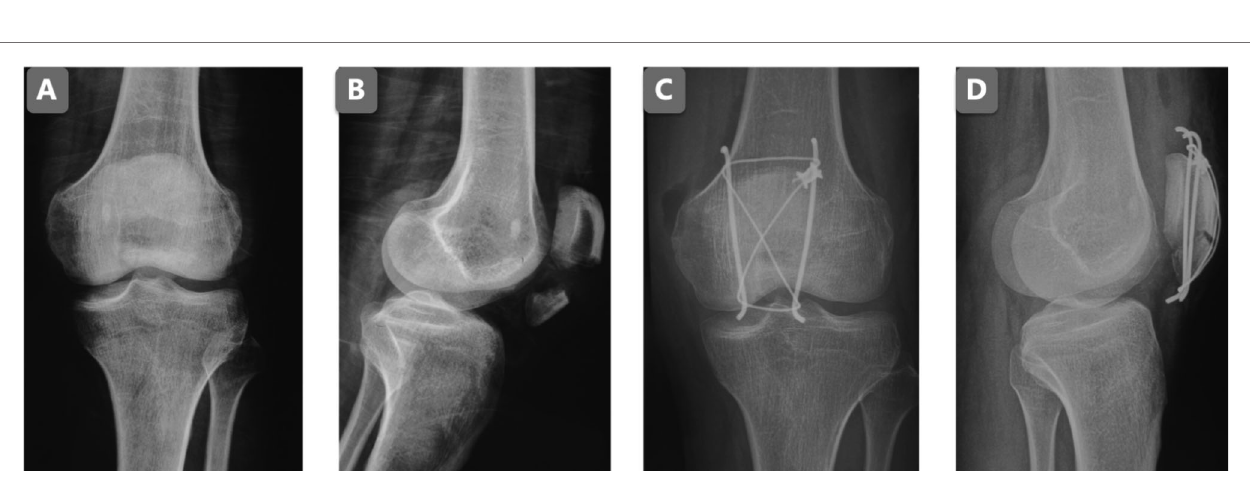
FIGURE 2 | The AP knee joint X-ray before the surgery ( A ); the lateral knee joint X-ray before the surgery ( B ); the AP knee joint X-ray post the modi fi ed method surgery ( C ); the lateral knee joint X-ray post the modi fi ed method surgery ( D ).